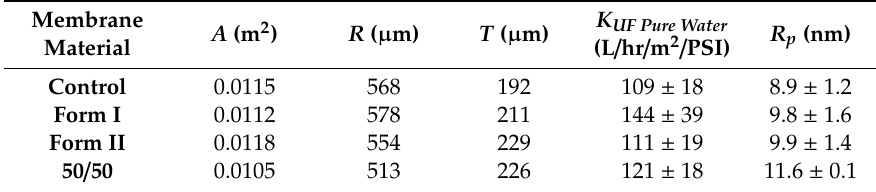
Table 1. Experimental values for sample membrane area, radius, thickness, pure water flux, and pore size.